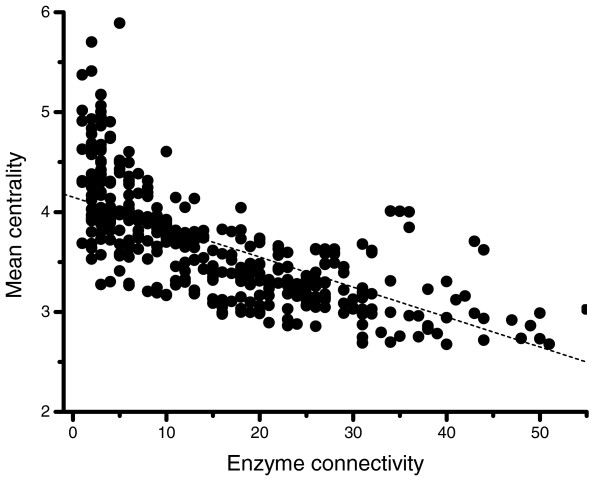
The correlation between enzyme connectivity and centrality in the yeast metabolic network. Spearman's rank correlation r = -0.74, P < 0.0001; Pearson's correlation r = -0.67, P < 0.0001. The centrality of an enzyme is equal to the mean length of network distances from the enzyme to all other enzymes in the networks (pairs of enzymes not connected by any path in the network were excluded from the calculation).